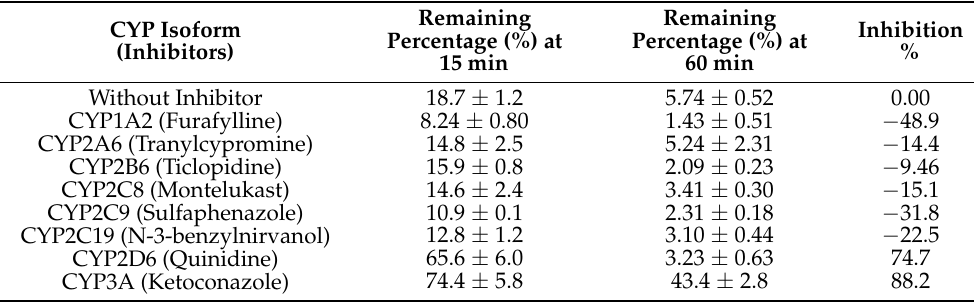
Table 10. The remaining percentage of ZB716 at 60 min in human liver microsomes, with and without CYP isoform chemical inhibitors ( n =